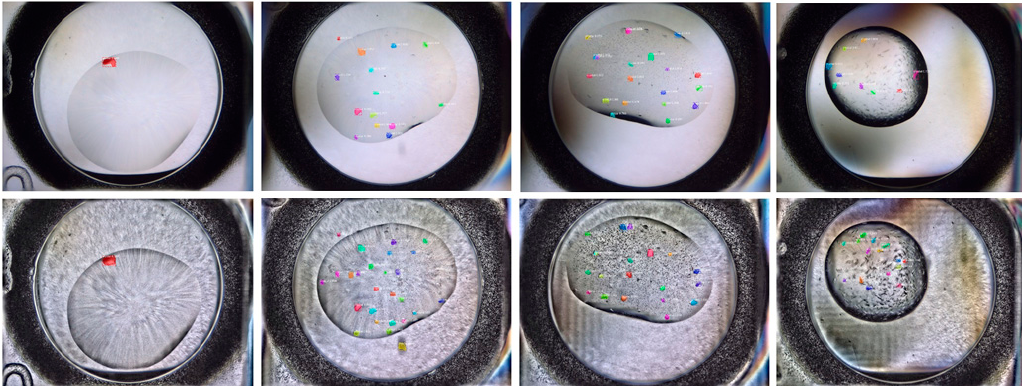
Figure 6. Result of protein crystal instance segmentation. The cases of instance segmentation without CLAHE are listed in the first row. The cases of instance segmentation with CLAHE are listed in the second row.